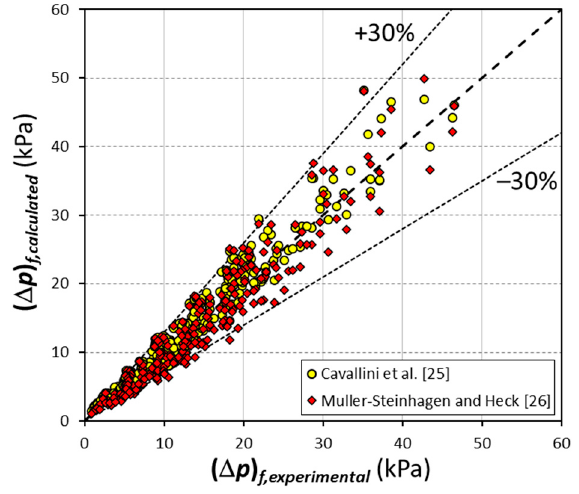
Figure 11. Comparison between calculated and experimental frictional pressure drops.